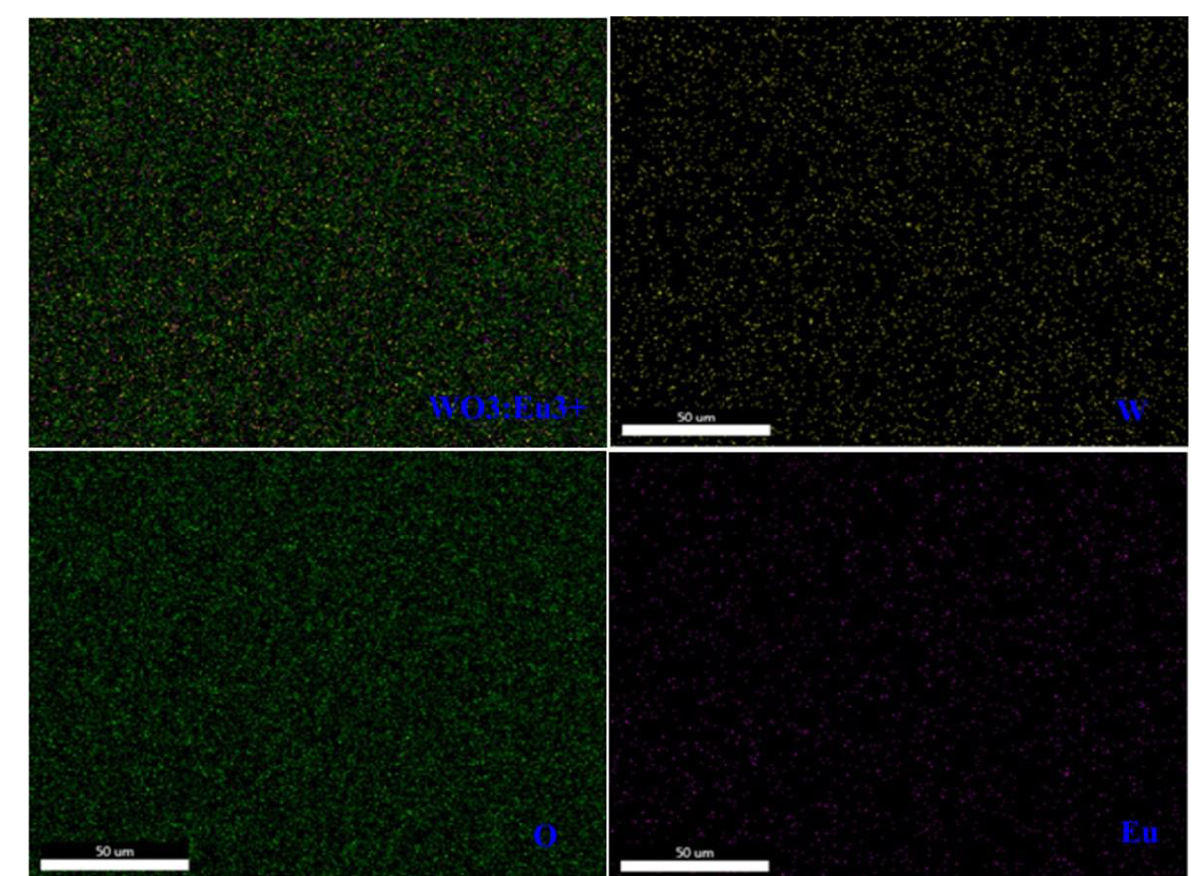
Figure 6. EDX spectra of the un-doped (WEu0) and 3 wt% Eu 3+ -embedded (WEu3) WO 3 films annealed at a temperature of 600 °C.